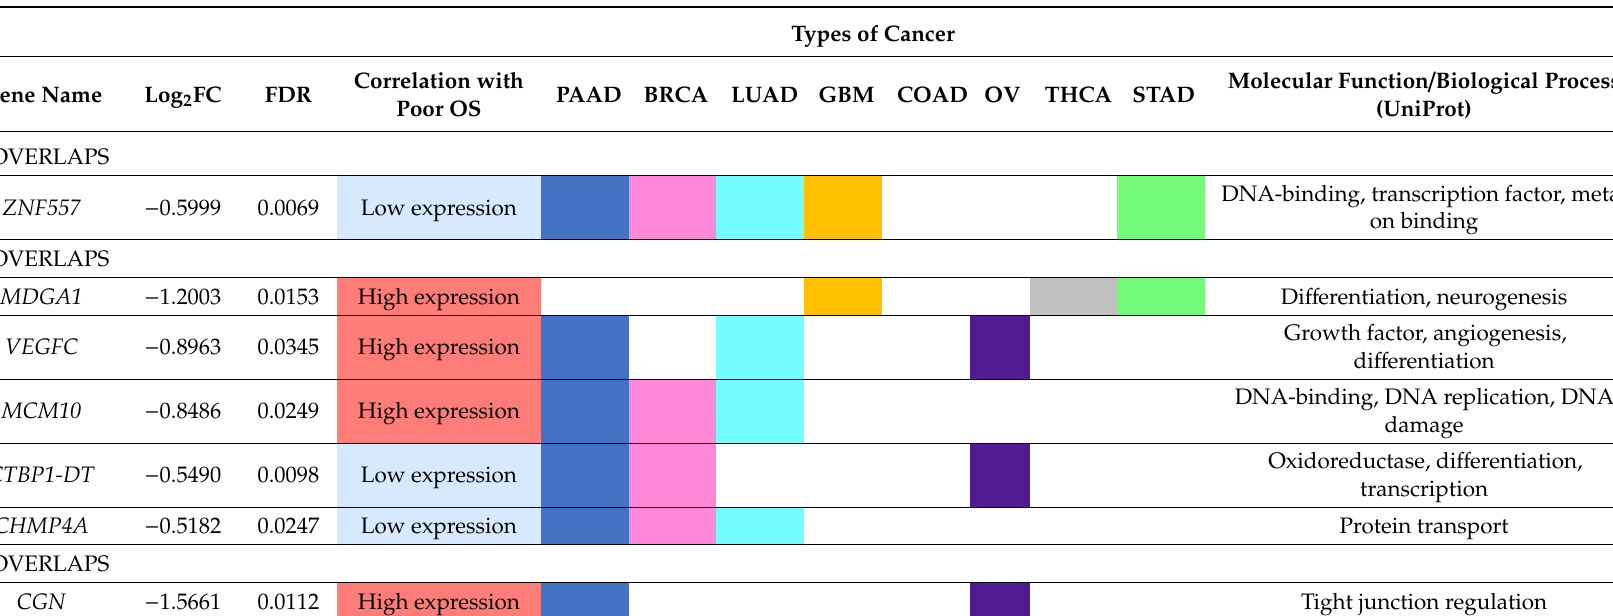
Table 2. Acid adaptation-upregulated genes significant in OS analysis in at least two types of cancers. Types of